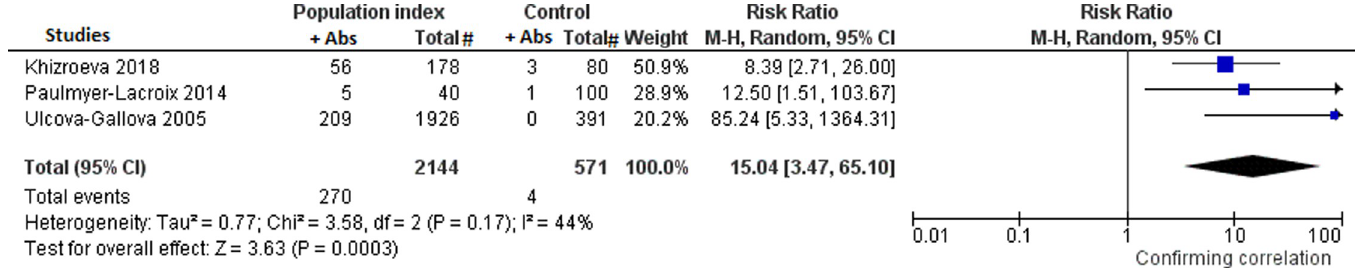
Fig 7. Meta-analysis assessing the risk for implantation failure in relation to the presence or not of anti-PL antibodies in the studies in subgroup B between women with at least two implantation failures in IVF-ET ( population index ) vs women with at least one successful spontaneous pregnancy or unselected healthy fertile women with no history of IVF-ET ( control ). Fig 7: meta-analysis assessing the risk for implantation failure in relation to the presence or not of anti- β 2 GPI antibodies.